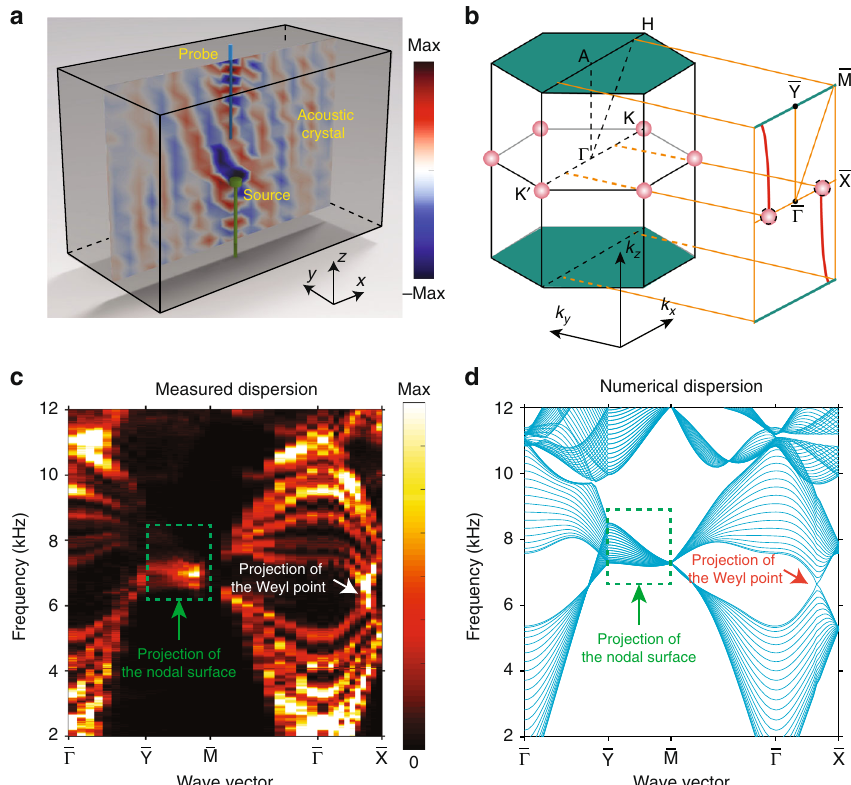
Fig. 2 Observation of a topological nodal surface and Weyl points. a Schematic of the experimental setup. The sound pressure fi eld distribution is measured along an x – z plane passing through the middle of the sample, with the source located 4 cm away from the plane in the y -direction. b Projection of the Brillouin zone onto the 2D measurement plane. The green plane (line) and red dots indicate the projected nodal surface and Weyl points, respectively. The red lines denote the surface-state arcs that connect the topological nodal surface to each Weyl point. c , d Measured and simulated projected band spectra. The color bar in ( c ) indicates the energy